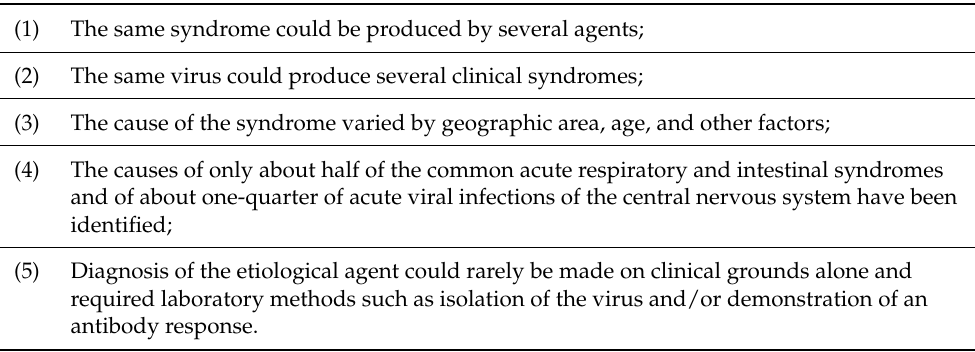
Table 4. Evans’ 1991 list of “Five Realities of Acute Respiratory Disease”